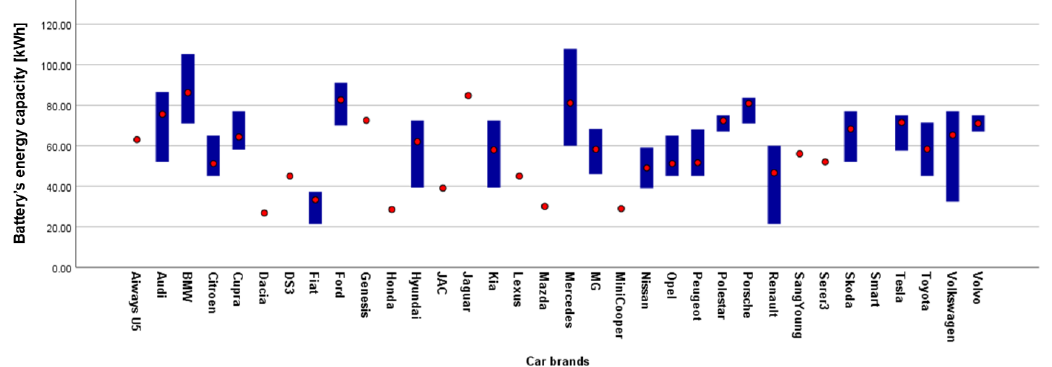
Figure 11. Range bar variation (min, max, mean) representation of battery’s energetic capacity vs. brands of cars.